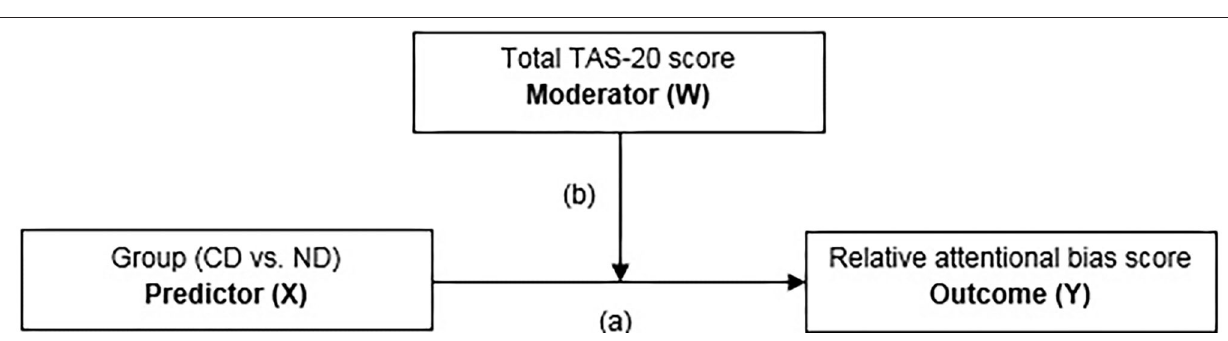
show a significant difference in relative ABS, F (2,100) = 0.05,